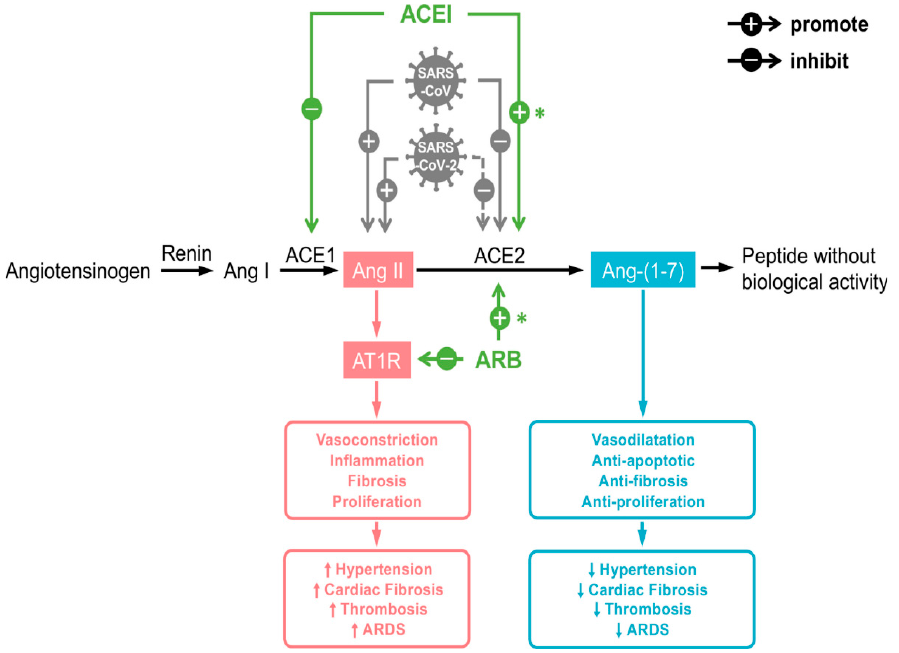
Figure 6. Working mechanisms for ACEi and ARB and relevance to SARS-CoV/SARS-CoV-2 infec- tions. Figure replicated from [82] with